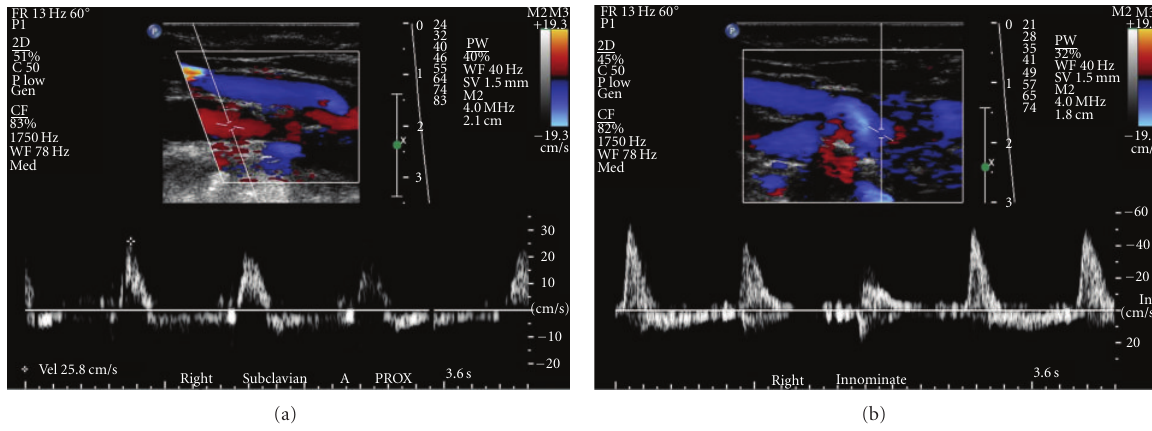
Figure 2: Color and pulsed-wave Doppler showing flow in right subclavian and innominate arteries. (a) Low velocity to- and- fro blood flow in the right subclavian artery. The very abnormal appearance of the spectral waveforms suggests more proximal severe stenosis. (b) To- and- fro blood flow in the innominate artery. There is spectral broadening present. Color flow image demonstrates retrograde flow in this single